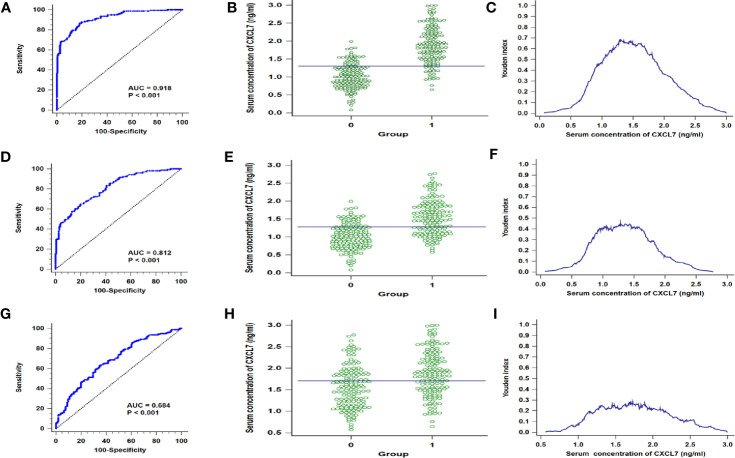
ROC curves for distinguishing the OCRC and non-OCRC patients from controls referring to serum CXCL7. (A–C) in discovery cohort. (A) AUC in OCRC patients. (B) Interactive dot diagram in OCRC patients. (C) Youden index in OCRC patients. (D–F) AUC, Interactive dot diagram and Youden index in validation cohort of OCRC patients. (G–I) ROC curves for OCRC and non-OCRC patients. *Groups: (B, E) 0 = Controls, 1 = OCRC group, (H) 0 = non-OCRC group, 1 = OCRC group.